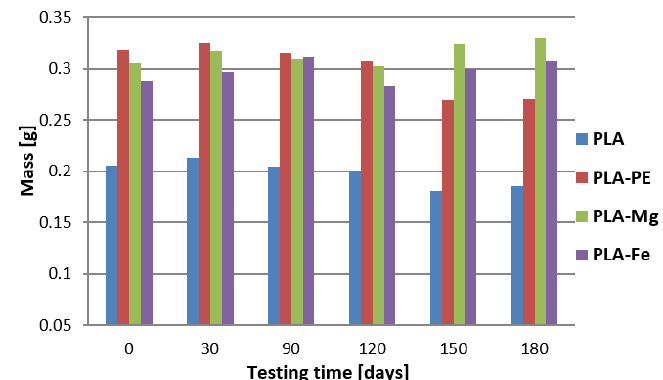
Figure 5. Degradation tests of the samples in the 0.9% saline solution.